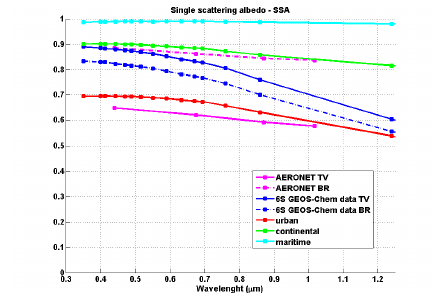
Figure 1. Aerosol volume size distributions from urban (red), continental (green) and maritime (cyan) 6SV aerosol standard types, AERONET data (magenta), and GEOS-Chem model (blue) corresponding to CHRIS image of 1 st May 2005 (dashed- line) over Tor Vergata (TV) and of 19 th August 2009 (solid line) over Bruxelles (BR).